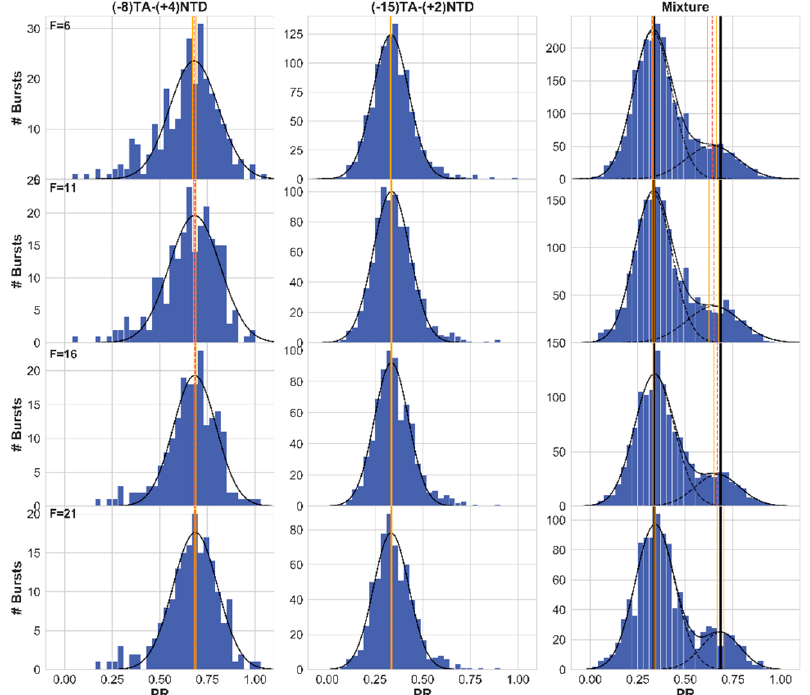
Figure 9. smFRET measurements of a mixture of two FRET constructs with different mean FRET efficiencies—increasing the value of the photon rate threshold, F , improves the accuracy of the retrieved mean FRET efficiency. From top to bottom, each panel shows the resulting FRET histogram (blue), the results of the best fit models (black), the best-fit mean FRET efficiencies (dashed red vertical lines; orange vertical lines show the error ranges), and the expected mean FRET efficiencies of each FRET sub-population (black vertical lines; calculated from the best fit results of fits of single FRET population to single Gaussian functions in the left and center panels). These results are for the measurements of FRET lacCONS promoter construct labeled with Cy3B at the nontemplate strand and ATTO 647N at the template strand at registers +4 and -8, respectively (left), +2 and -15, respectively (center) and a measurement of their mixture (right). The best fit values are also reported in Table S4.